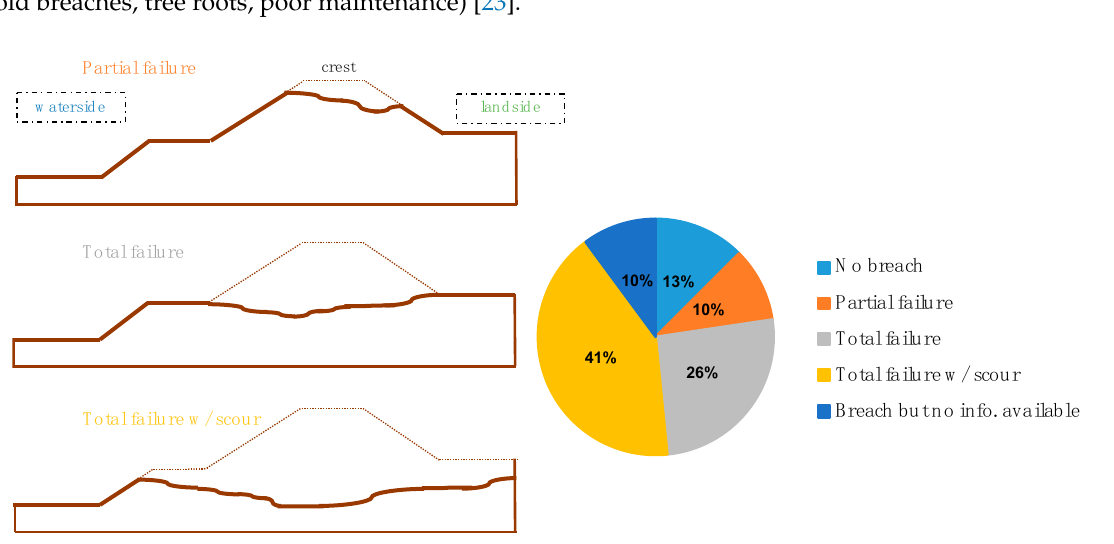
Table 2. Overview of the main failure mechanisms for the 2002 and 2013 events.